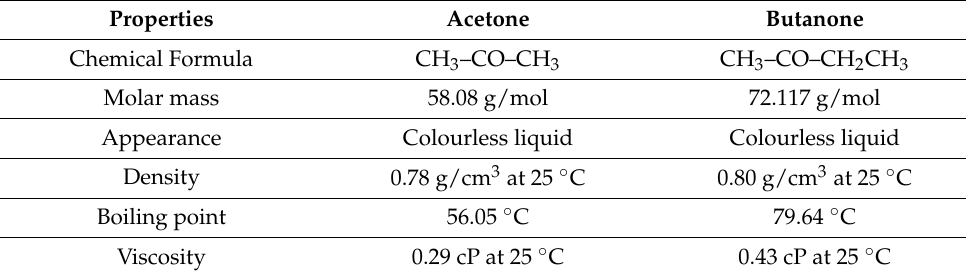
Table 1. Physicochemical properties of acetone and